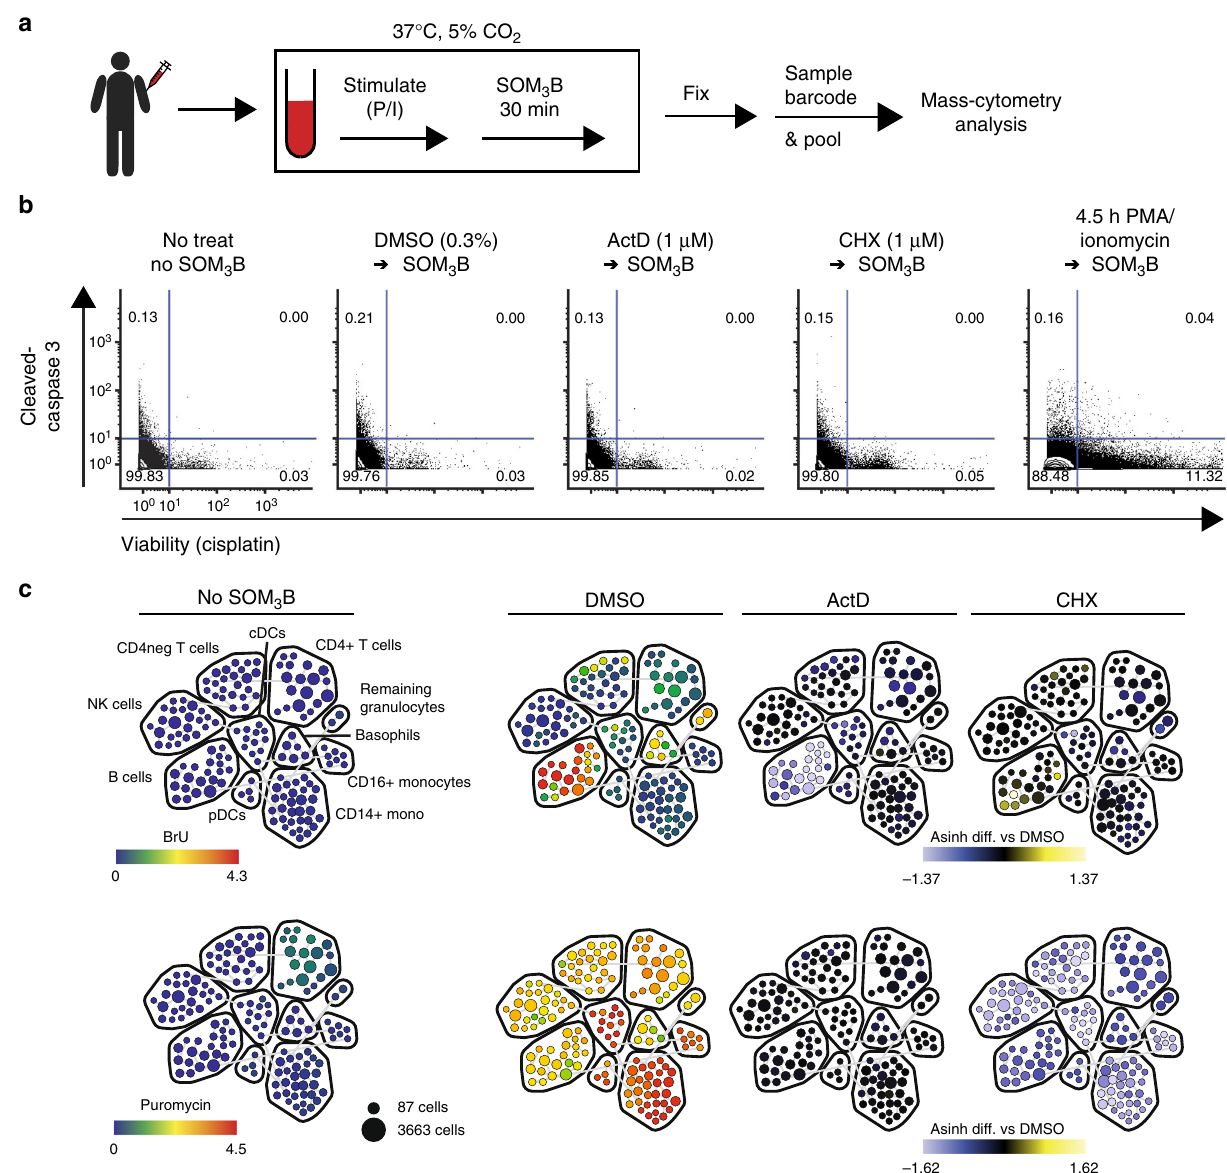
Fig. 3 SOM 3 B does not interfere with primary immune sample cell fi tness and predictively re fl ects biosynthesis activity. a Whole blood from a healthy donor stimulated in a time course prior to SOM 3 B analysis (P/I; PMA/Ionomycin). b Biaxial plots with inlaid frequency of whole blood mononuclear cells undergoing apoptosis (cleaved-Caspase3 positive) and non-viable cells (positive cisplatin staining). Inlaid quadrant numbers indicate the percent of total events within each gate. Approximately 100,000 events displayed for each condition. c Manually annotated SPADE map of in silico gated peripheral immune mononuclear cell subsets in whole blood from a single healthy donor not labeled with SOM 3 B reagents (far left), or treated with DMSO (middle left), Actinomycin D (middle right), and Cycloheximide (far right) prior to SOM 3 B labeling. Rainbow color overlay scaled to indicate median expression for each cluster (BRU — top, Puromycin — bottom). Blue-yellow color overlay scaled to indicate the difference between the transformed median value (ArcSinh cofactor of 5) of a given cluster from the complementary control cluster (DMSO). Weak puromycin signal in “ No SOM3B ” is derived from background isotopic contamination in CD4 + T cells with high CD4 expression (CD4-Gd157 into Puromycin-Gd158). Number of cell events displayed; 130,000 – 160,000 single cell events for each map, experiments were performed multiple times, representative plots and maps all time-points into a single tube, followed immediately by antibody staining (Supplementary Table 2).